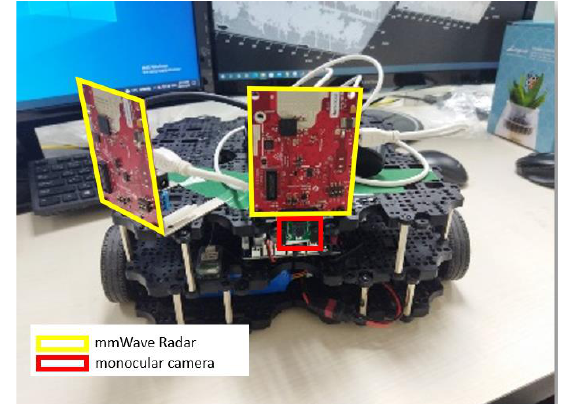
Figure 6. The experimental setup of visual radar system